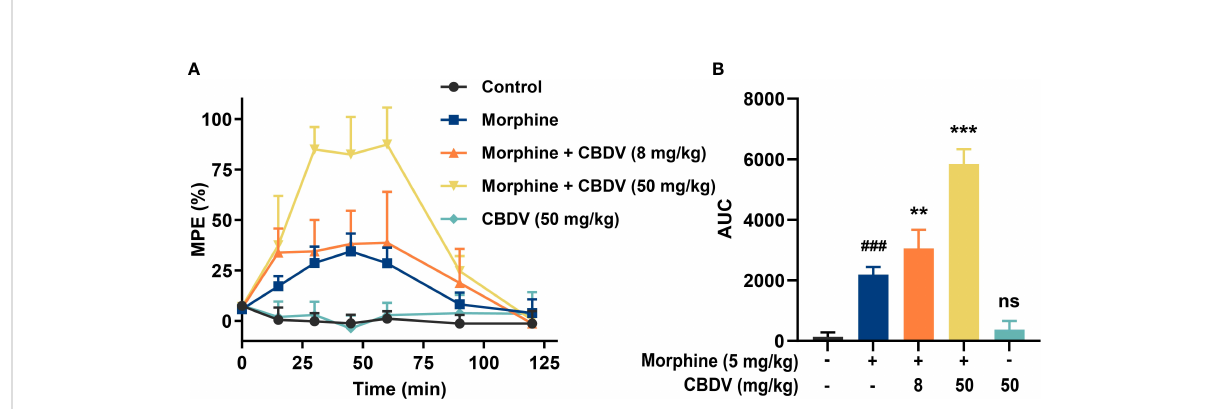
FIGURE 6 CBDV potentiates morphine-induced antinociception. (A) Intraperitoneal co-administration of morphine (5 mg/kg) and CBDV produced a signi fi cant potentiation of morphine hot plate analgesia. (B) The area under the curve (AUC) curves shown in panel (A) . Data were presented as the mean ± S.E.M. n = 5/group; The P-value was set at ### P < 0.001 versus the control group; **P < 0.01, ***P < 0.001 versus the morphine group; ns, not signi fi cant versus the control